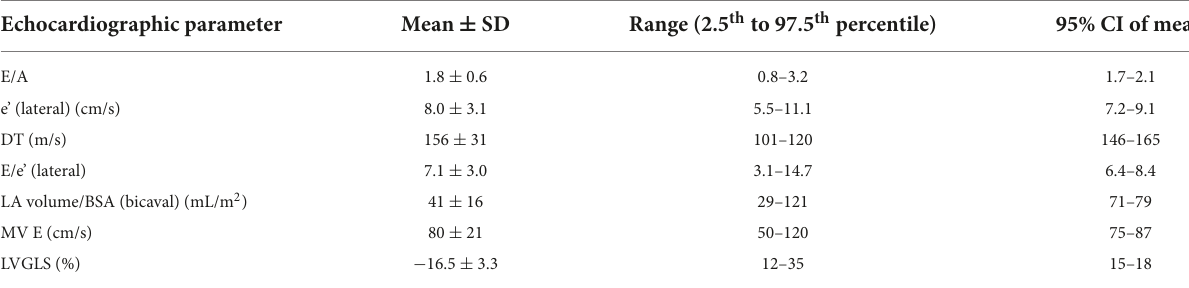
TABLE 1 Reference values for diastolic parameters evaluated by echocardiography in heart transplant patients. Reference values for diastolic parameters in HTx patients Echocardiographic